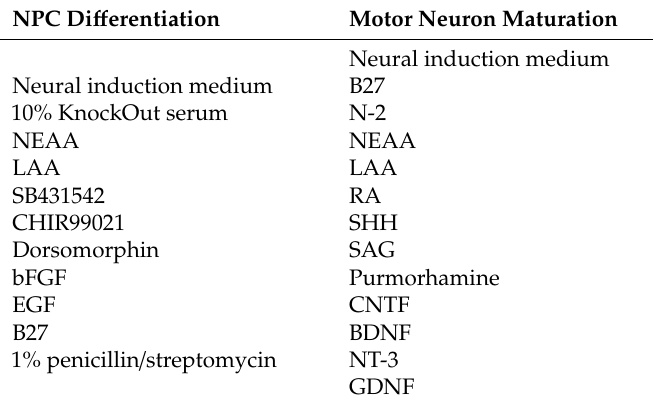
Table 4. The most commonly used additives that promote di ff erentiation of iPSCs into neural precursor cells (NPCs) and, further, to motor neurons